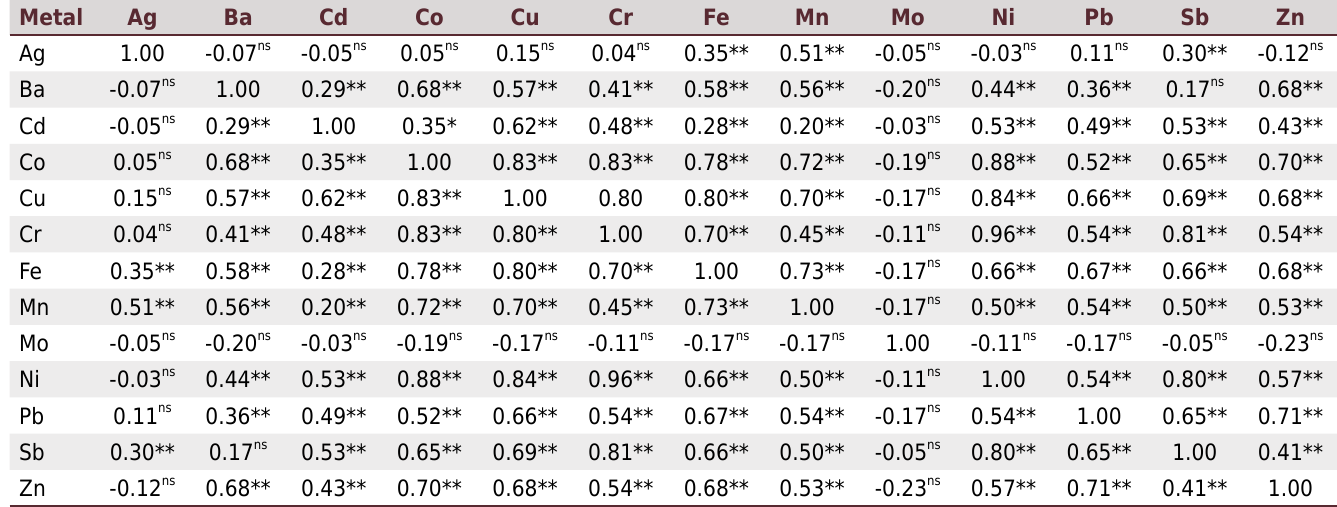
Table 6. Pearson correlation coefficients between heavy metal concentrations in soils of Paraíba Metal